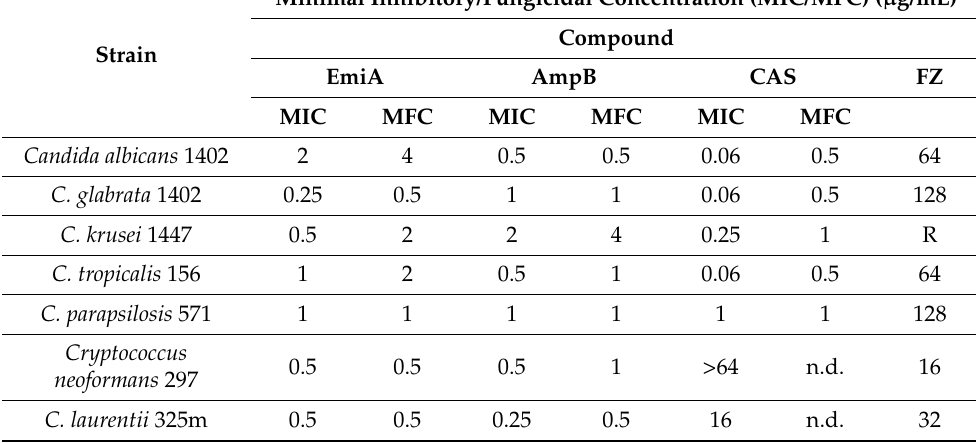
Table 5. MIC and minimal fungicidal concentration (MFC) of emericellipsin A against clinical yeast isolates.